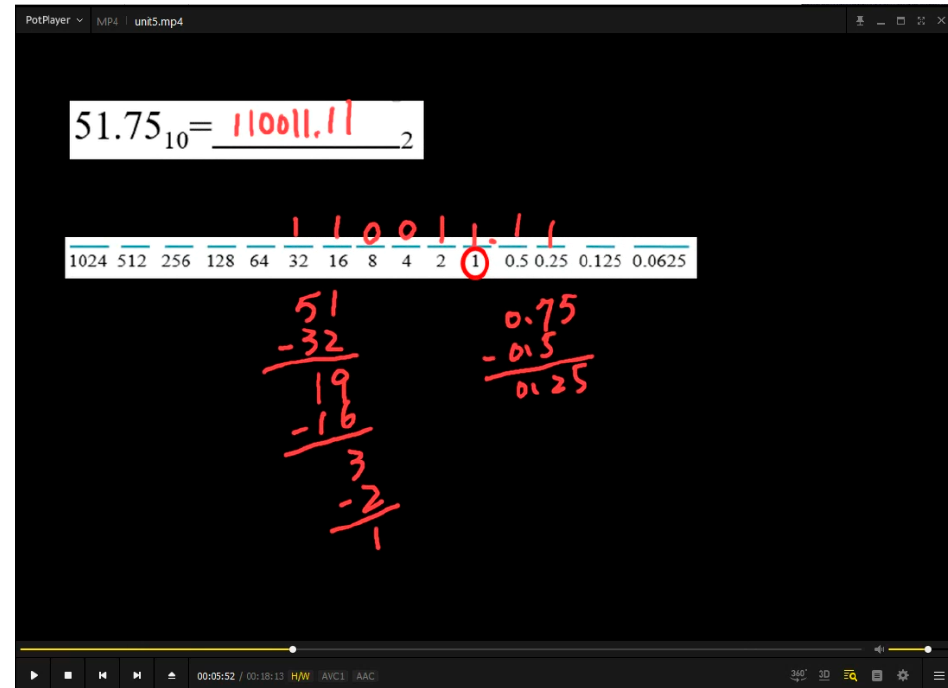
Figure 4. Structure of implementation process.